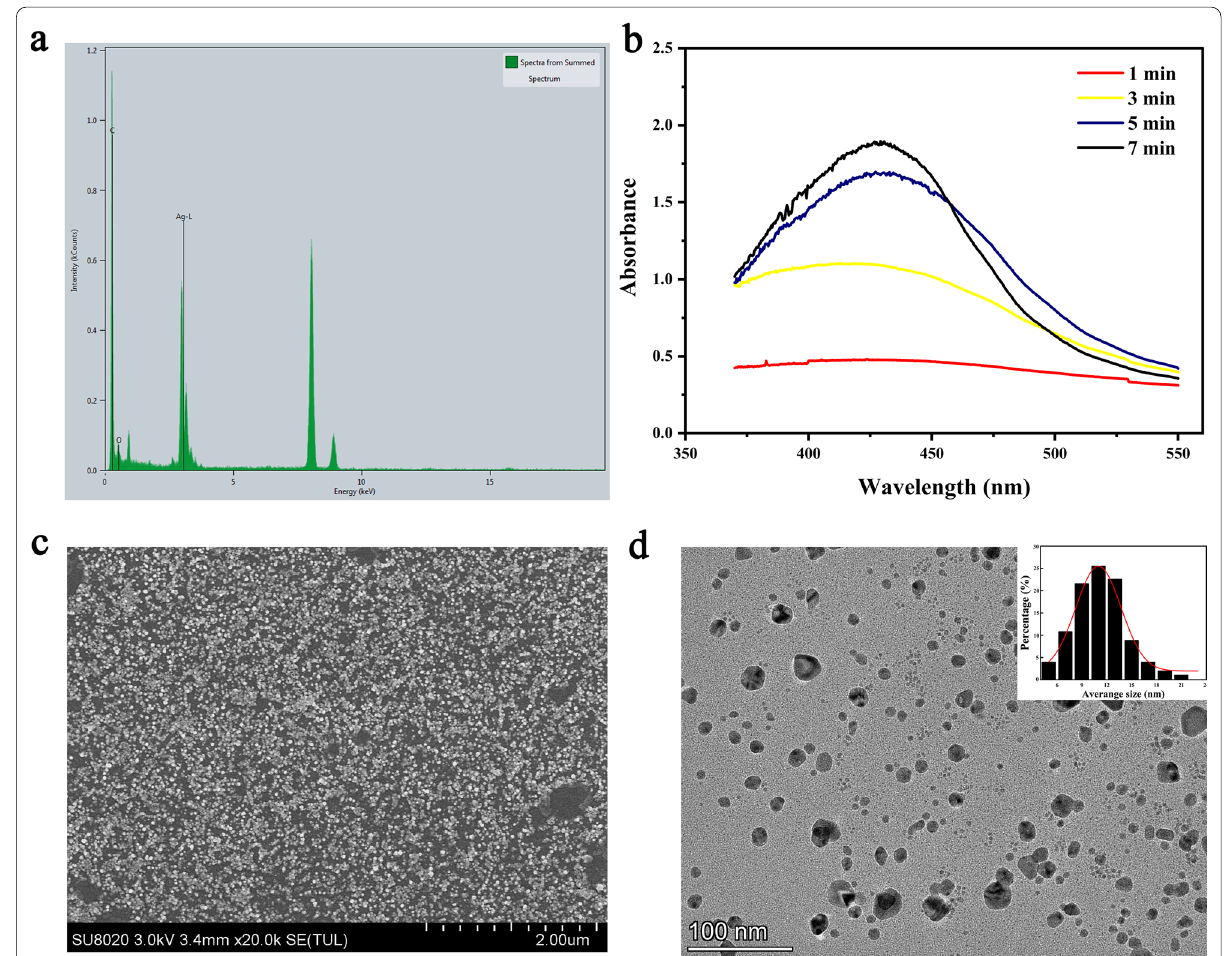
Fig. 1 Analysis of the characteristics of biosynthesized AgNPs. a Typical signal of Ag element in the energy spectrum of biosynthesized AgNPs. b UV–vis spectrum of biosynthesized AgNPs. c Scanning electron microscopic image of biosynthesized AgNPs. d Determination of the average particle diameter of biosynthesized AgNPs by transmission electron microscopy